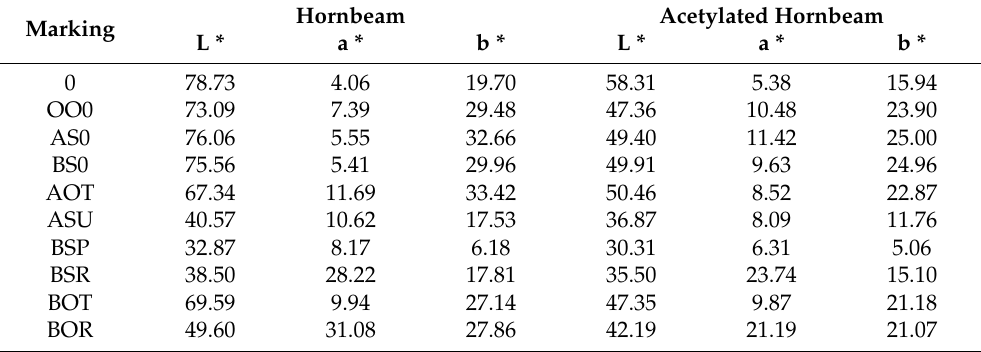
Table 3. Color coordinates of hornbeam and acetylated hornbeam, uncoated and coated with various oils and